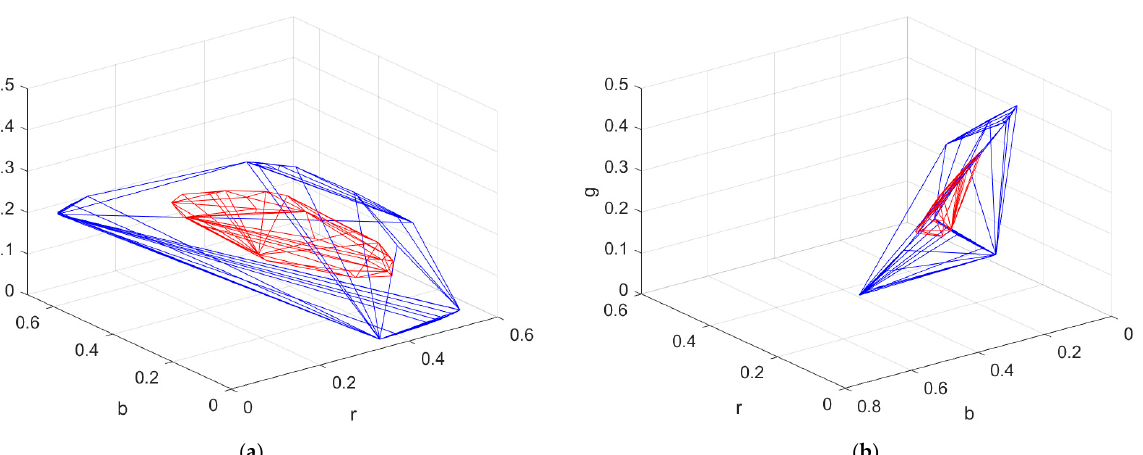
Figure 5. ( a ) The convex hull of the reference samples in the rgb normalized signal space for the RGBF camera. Reference and outside samples are shown with red and blue dots, respectively. ( b ) The same as ( a ) except for viewing angle.